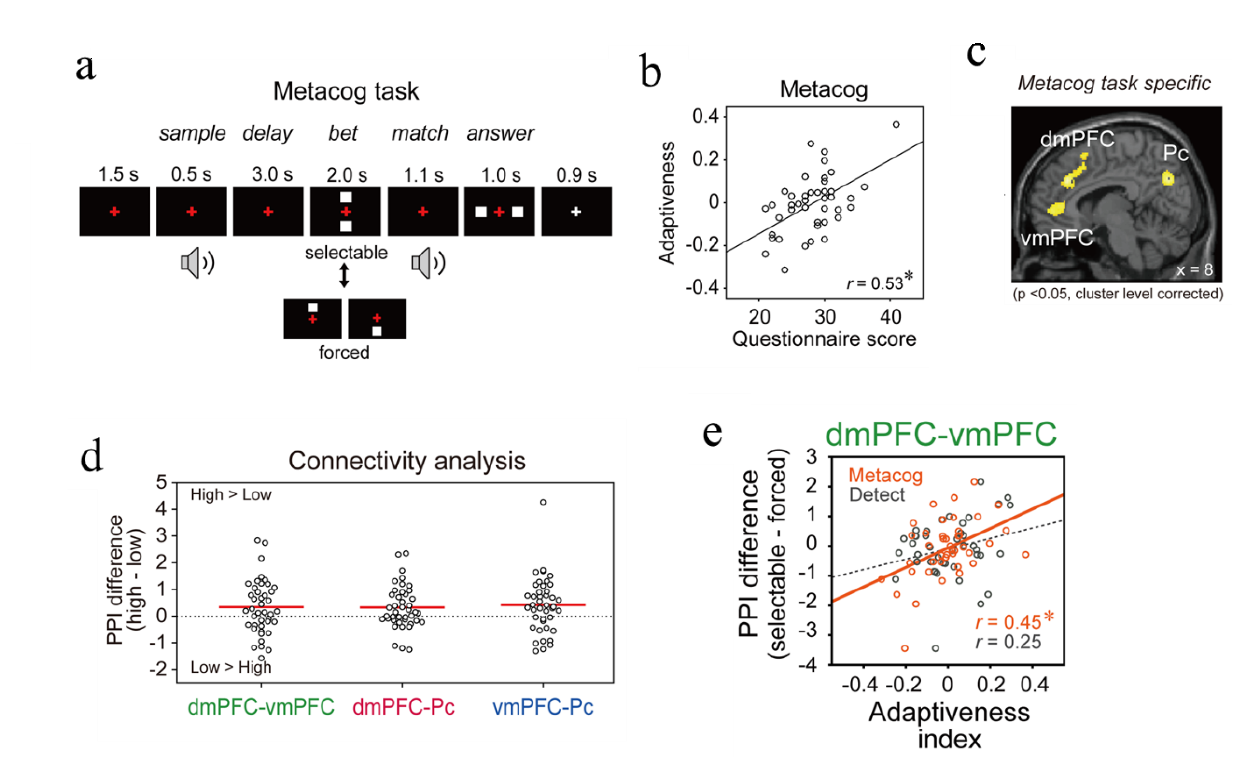
Figure 2 . Schematic representations of the (a) applied task in the human fMRI experiment and (b) defini tion of the “adaptiveness index, ” (c) correlation of the adaptiveness index against the questionnaire score that measures the degree of daily reliance on prospective metacognition, (d) difference in functional connectivity indices in selected high-risk/return bets compared to the forced high-risk/return bets among dmPFC, vmPFC, and Pc, (e) correlation of the functional connectivity increment between dmPFC and vmPFC in selected high-risk/return bets compared to the forced high-risk/return bets against the adaptiveness index. One cycle represents one participant. * p < .01. Adapted from Figures 1A, 3C, 4B, and 5A in Yuki, S., et al. (2019). Regulation of action selection based on metacognition in humans via a ventral and dorsal medial prefrontal cortical network. Cortex , 199 , 336 –